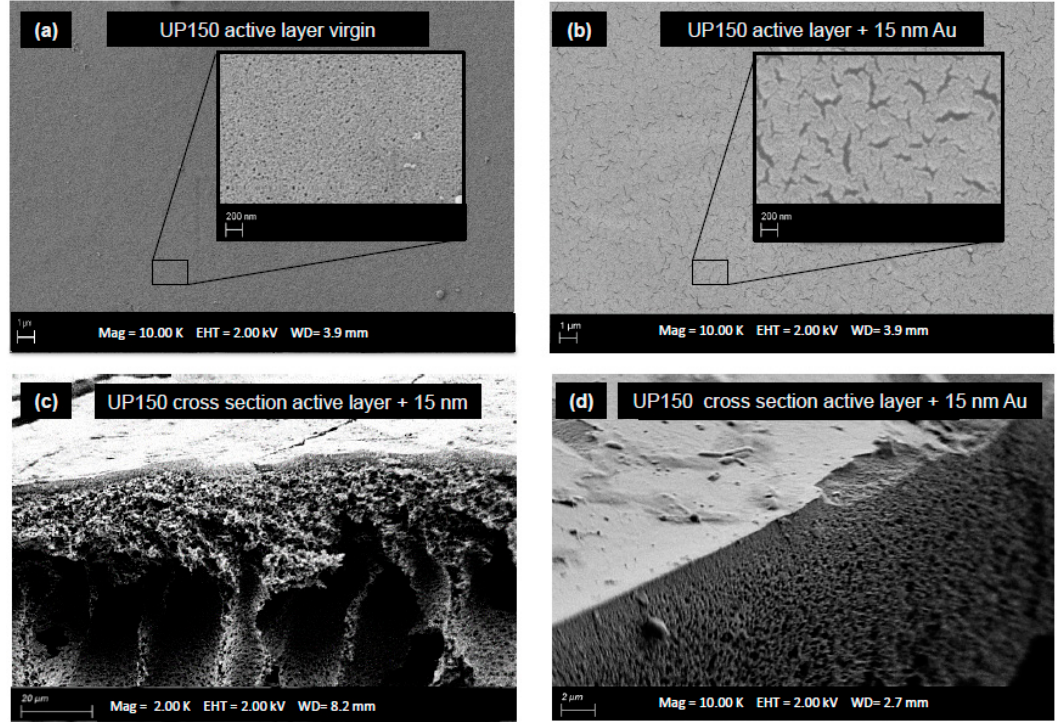
Figure 3. Scanning electron microscopy (SEM) imaging: ( a ) virgin UP150 with 3.6 nm Au coating for SEM contrast, 10 k× and 100 k×; ( b ) UP150 + 15 nm Au, 10 k× and 100 k×; ( c ) cross section of coated membrane, 2 k×; ( d ) cross section of active layer + 15 nm Au,10 k×.